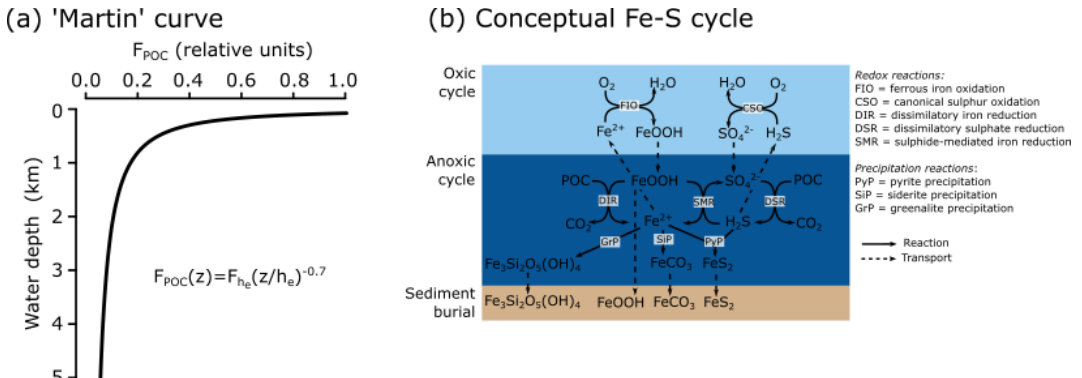
Figure 4. (a) Example of the Martin curve for vertical organic matter fluxes in the ocean. (b) Conceptual description of the iron–sulfur cycle implemented in the model. For simplicity, only FeOOH (oxidized iron) and Fe 2 + (reduced iron) are depicted, but the model includes different iron species in both the oxic and anoxic states. Interaction between the methane cycle and sulfur cycle is omitted for clarity. See text for details.